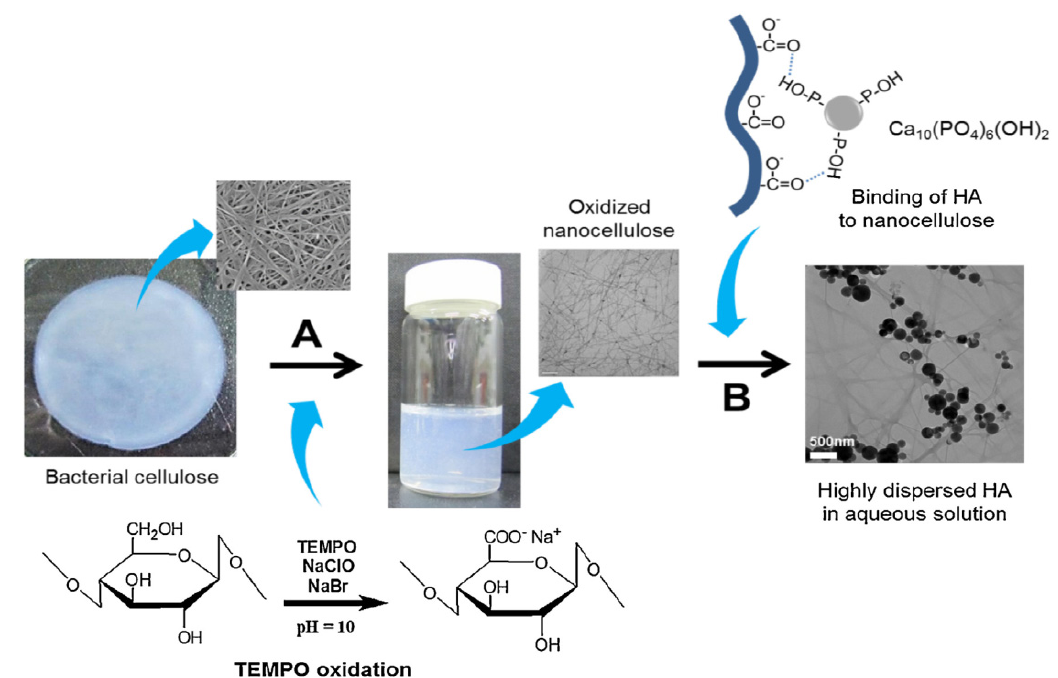
Figure 6. Schematic representation of TEMPO-oxidation of BNC (A) and the colloidal dispersion of HAp nanoparticles (B). Reproduced with permission from [76]. Copyright 2015 Elsevier.